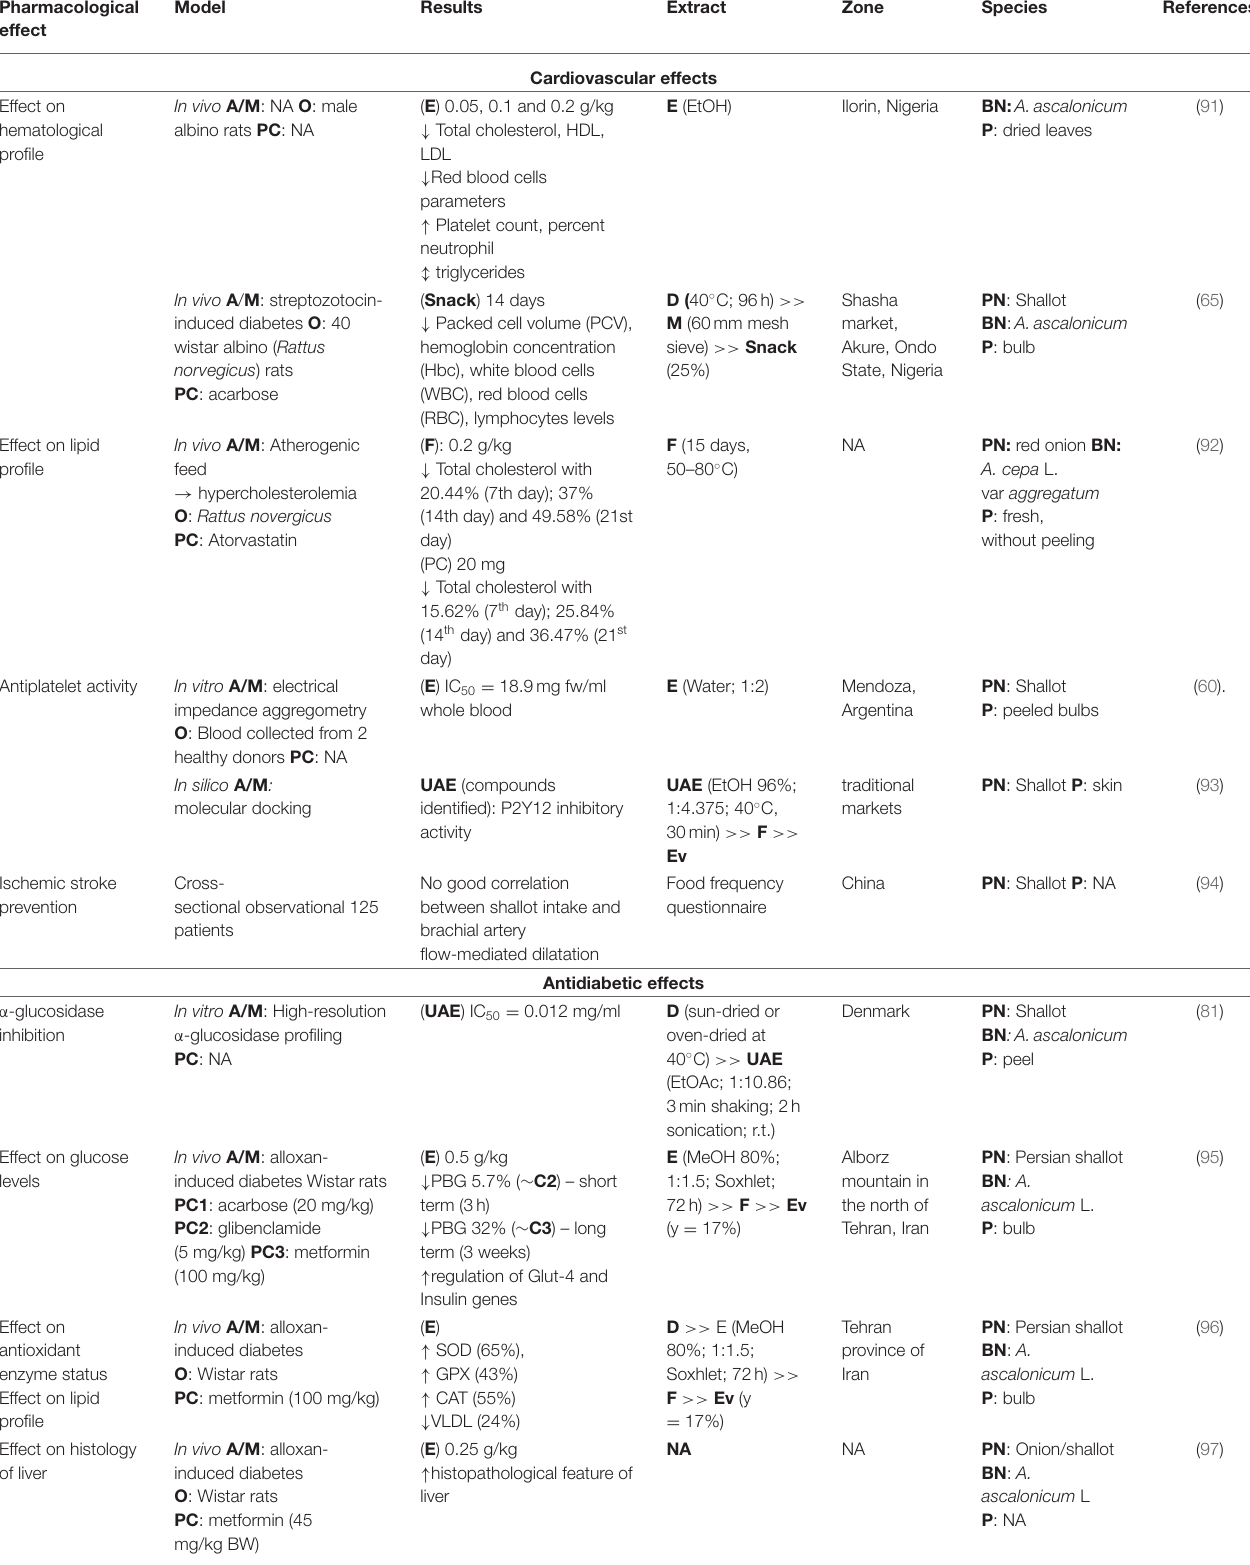
TABLE 3 | Summary of main cardiovascular, antidiabetic, cytotoxic and other pharmacological effects exerted by shallot